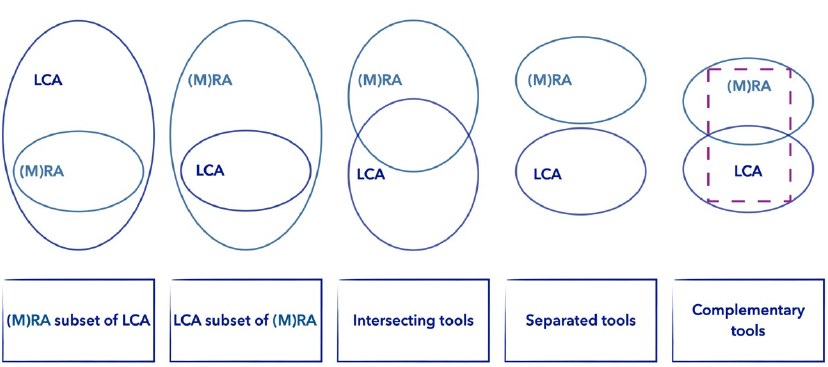
Figure 3. Alternative approaches od (M)RA and LCA in terms of simplified Venn diagrams—redrawn from Ref. [13]. To devise a more general protocol that integrates both approaches (i.e., MRA and LCA), it is useful to compare their specific features.